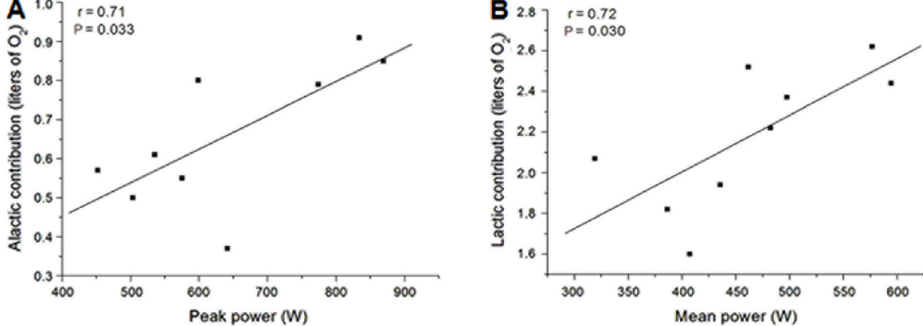
Figure 1. Relationships between peak power and alactic contribution ( panel A ) and between mean peak and lactic contribution ( panel B ). The Pearson’s product-moment coefficient test was used for statistical